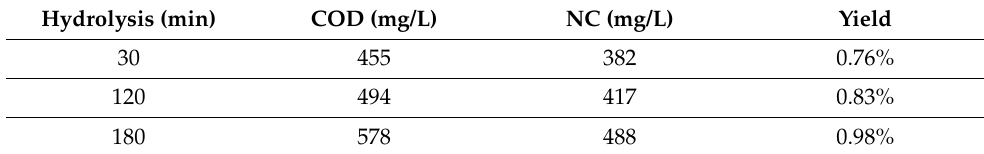
Table 1. COD test results of 30-, 120- and 180-min hydrolysis of Whatman filter paper. Hydrolysis (min) COD (mg/L) NC (mg/L) Yield 30 455 382